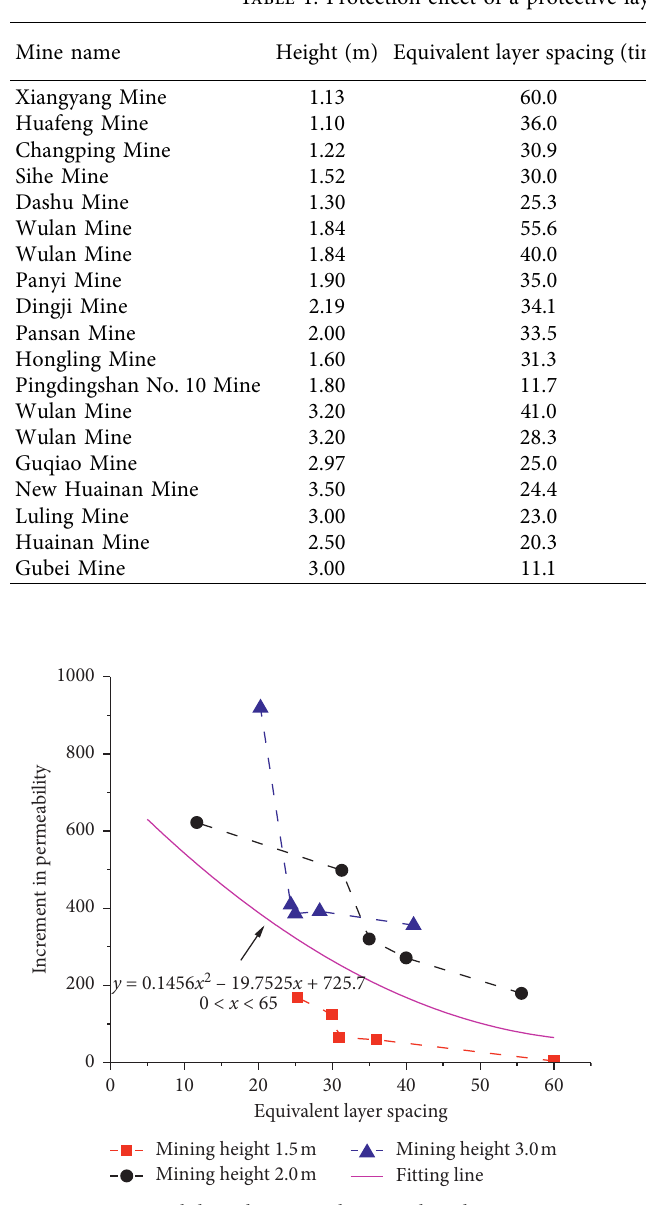
Figure 1: Permeability change with equivalent layer spacing at different mining heights of the protective